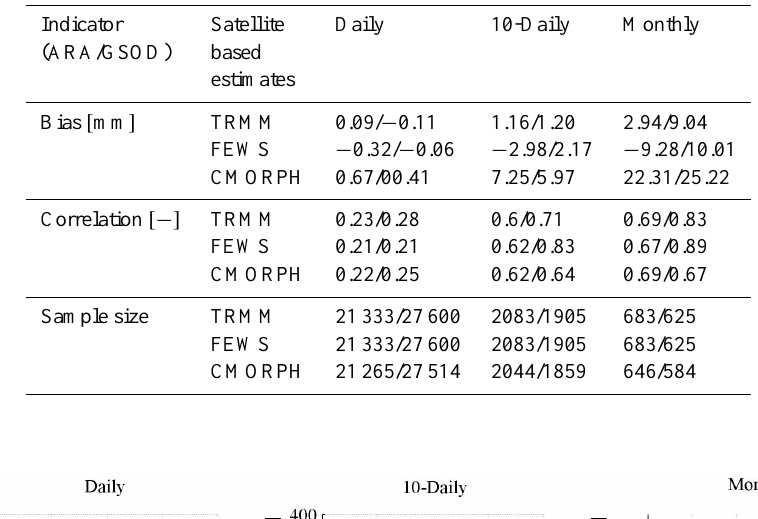
Table 3. Characteristics of the global satellite versus gauge data series.